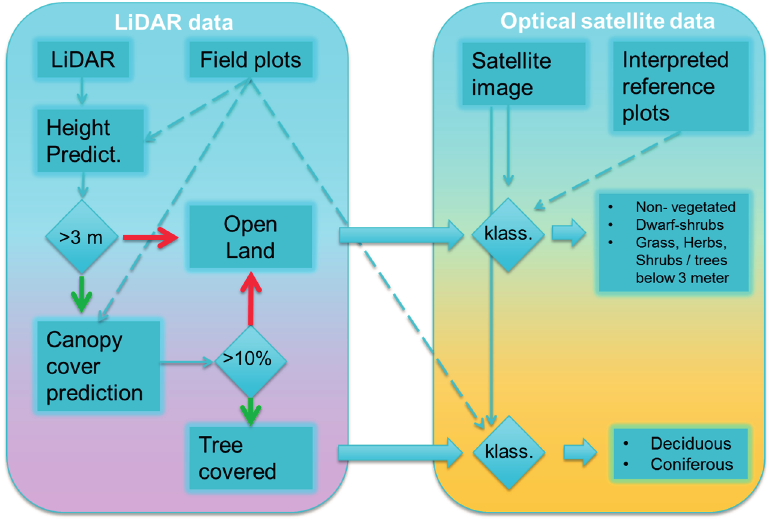
Figure 4. Proposed workflow to classify a group of NILS 5 × 5 km squares. Left box contains the workflow for lidar predictions which uses only existing field data from NFI and NILS. Right box contains the workflow for predictions from optical satellite data. Red arrow indicates negative answers and green